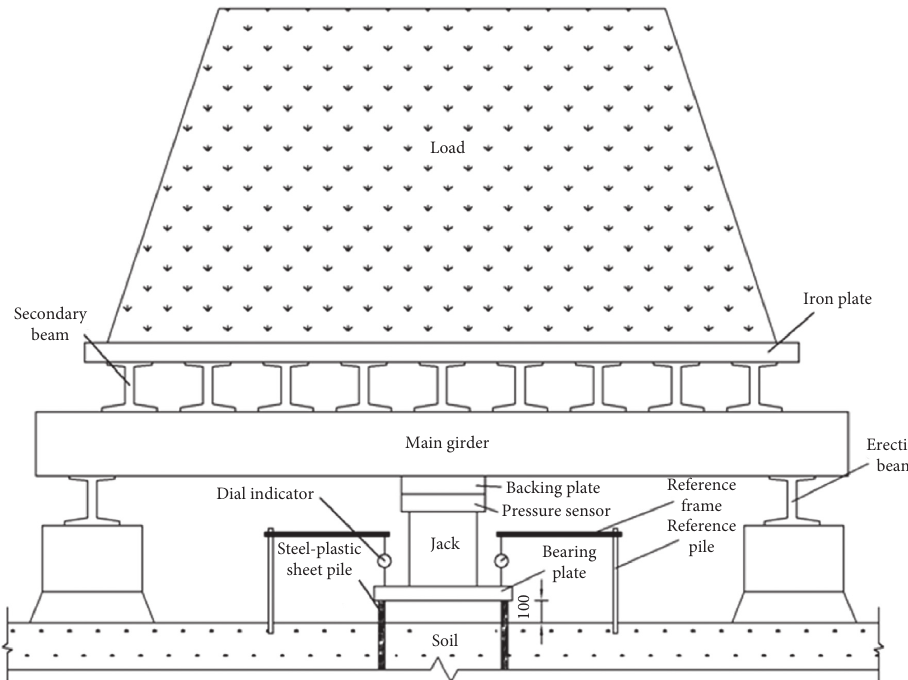
Figure 6: Schematic diagram of the static load for Test 1.